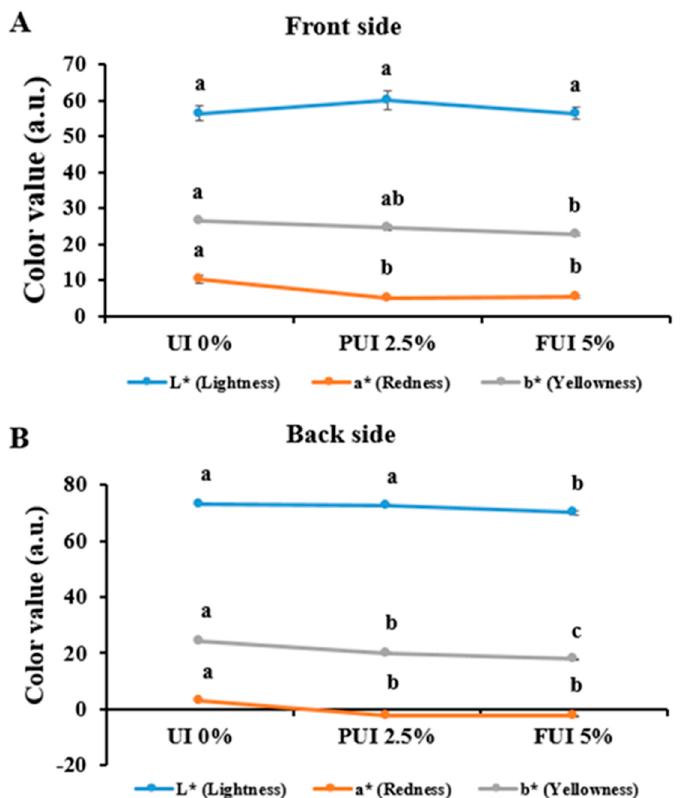
Figure 3. Changes in color values in both ( A ) front side and ( B ) back side of cookies prepared with UI 0%, PUI 2.5%, and FUI 5% UI. The dimension L* means lightness, with 100 for white and 0 for black appearance; a* indicates redness for positive value and greenness for negative value, b* indicates yellowness for positive value and blueness for a negative value. Data represent the mean ± SE of 3 observations, where groups not sharing a letter are expressed as significantly different ( p < 0.05).